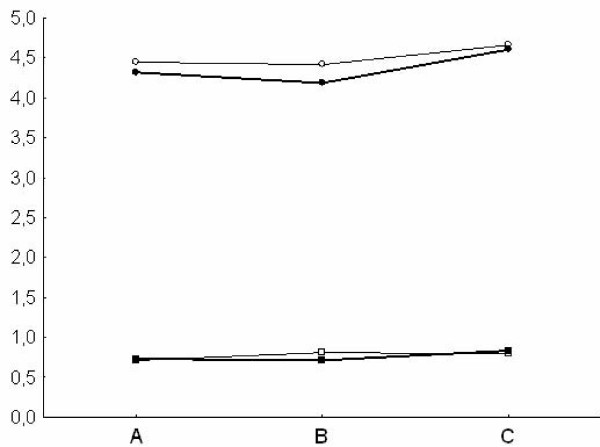
Middle Cerebral Artery: Mean of Depth (circle) and Pulsatility index (square) in TCD (narrow line) and TCCS (thick line) in the three groups of patients A, B, C.